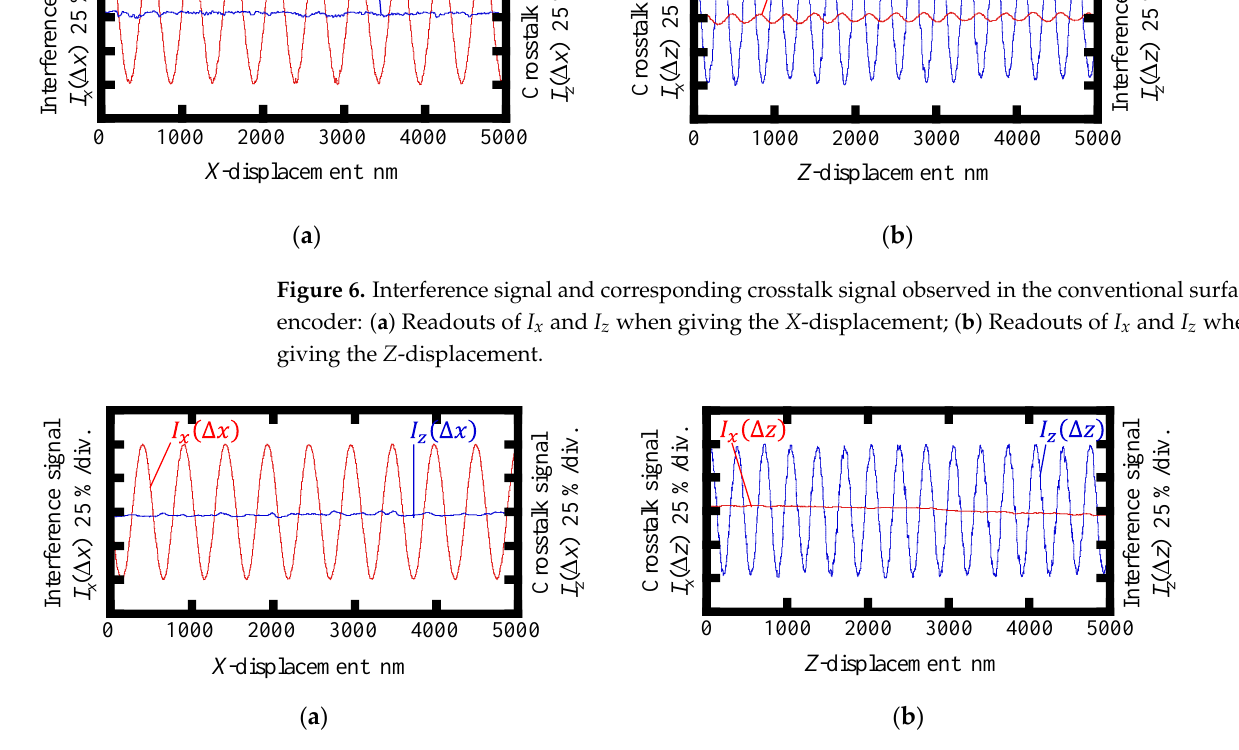
Figure 7. Interference signal and corresponding crosstalk signal observed in the proposed surface encoder: ( a ) Readouts of I x and I z when giving the X -displacement; ( b ) Readouts of I x and I z when giving the Z -displacement.